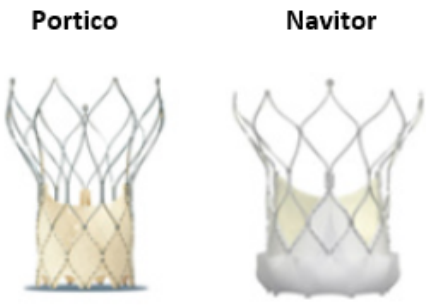
Figure 3. The ACURATE neo and neo2 self-expandable valve consist of a porcine pericardial tissue bio-prosthesis stitched into a self-expanding Nitinol stent and covered on the inside and outside with an anti-PVL porcine pericardial skirt. The open upper frame of the device open frame provides unrestricted access for future interventions.